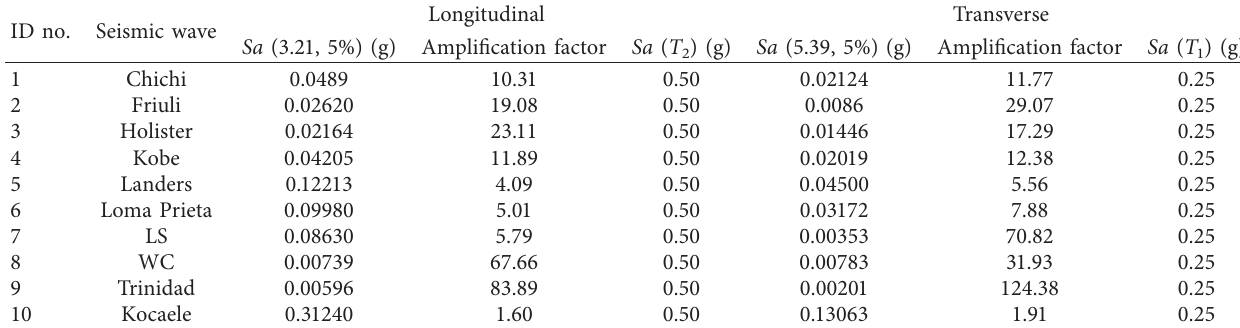
Table 4: The adjustment of 10 seismic waves.